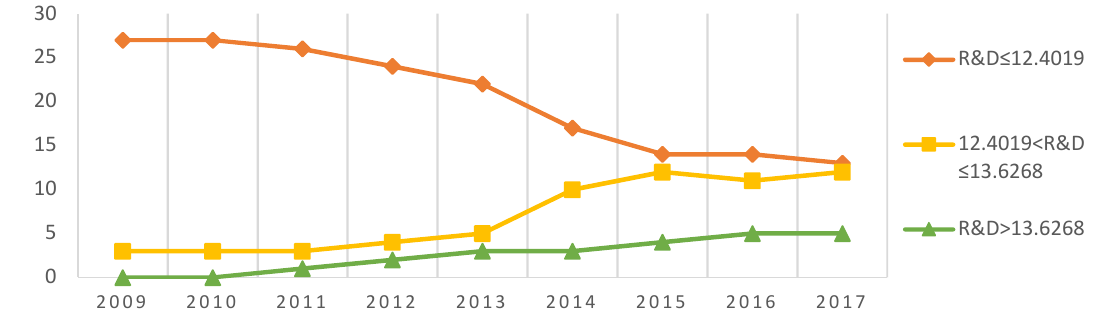
Figure 3. Technological innovation threshold level time Figure 3 Technological innovation threshold level time trend.